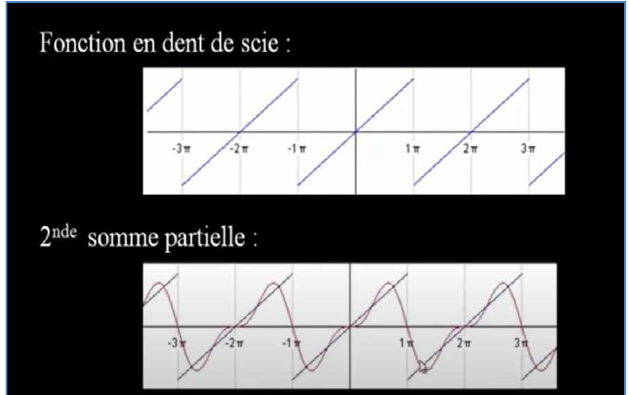
Fig. 1. Un exemple des médiateurs visuels graphiques relatifs à la fonction en dent de scie et une de ses